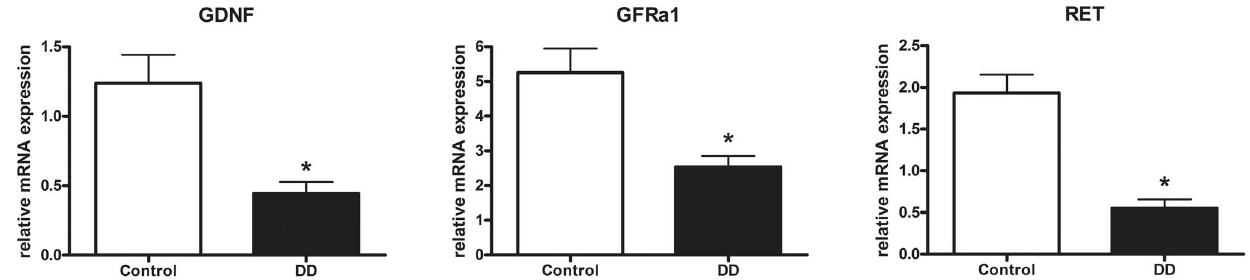
Figure 1. mRNA expression of the GDNF system in the muscularis propria of the human colon. mRNA expression of GDNF (A) and its receptors GFR a 1 (B) and RET (C) is significantly down-regulated in patients with DD compared to controls. mRNA levels are determined by qPCR, expression of target genes is normalized to mRNA expression of the house-keeping gene HPRT. Data are shown as mean + / 2 SEM, n=20 (controls) and n=21 (DD), *p , 0.05 vs. control.